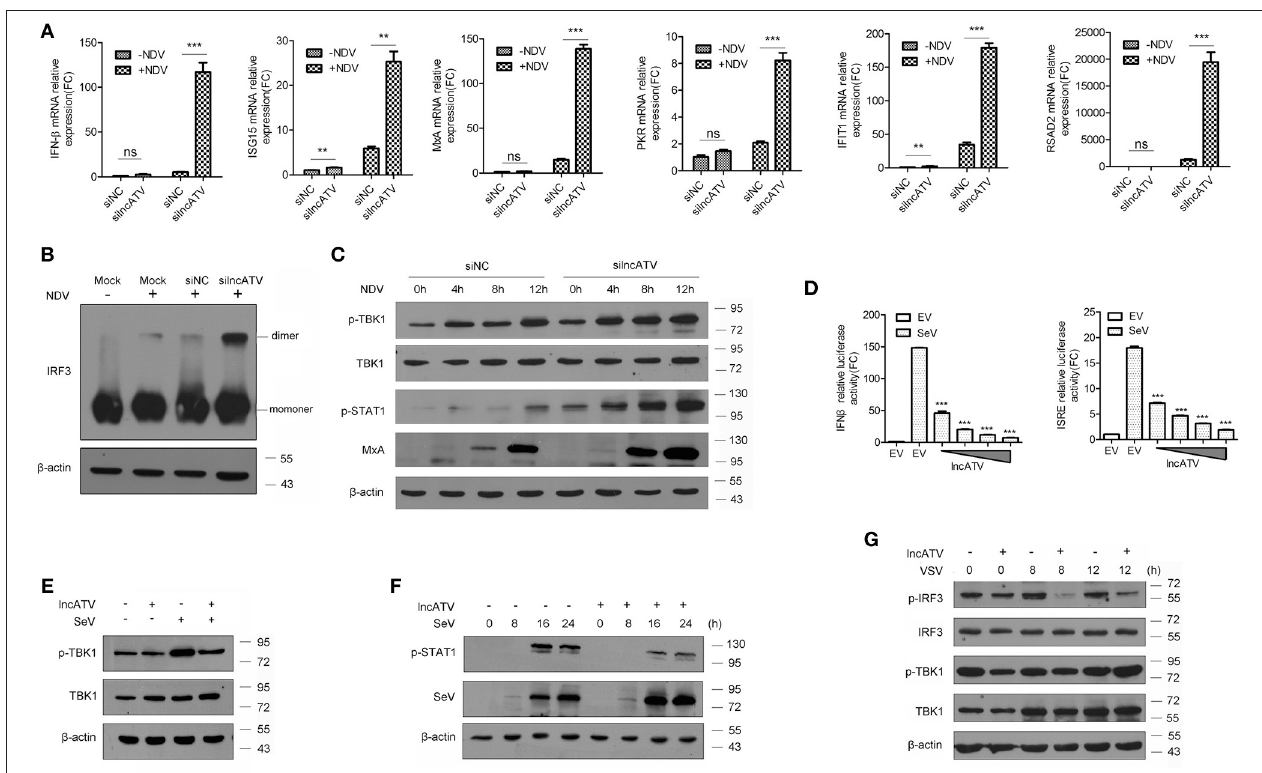
FIGURE 3 | Regulation of lncATV on the host innate immune response. (A) Huh7 cells were transfected with negative control siRNA (siNC) or siRNA targeting lncATV at 48h prior to infection. NDV (MOI = 0.01) was inoculated and allowed for another 16h infection to trigger innate immune response. Total RNA was isolated, and qRT-PCR was performed to measure the expressions of IFN β , ISG15, MxA, PKR, IFIT1, and RSAD2. (B) Dimerization of IRF3 was measured by native-PAGE and Western blotting. (C) Immunoblot analysis of phosphorylated proteins in lncATV knockdown and control Huh7 cells infected with NDV for indicated hours. (D) IFN β or ISRE promoter-driven reporter construct was co-transfected with either lncATV overexpressing plasmid or empty vector (EV) into HEK293T cells. Luciferase activities were determined in the absence or presence of SeV infection. (E,F) HEK293T cells were transfected with lncATV overexpressing plasmid or empty vector as controls and then challenged with SeV (MOI = 1) for the indicated time courses. Phosphorylated TBK1 (E) or STAT1 (F) was detected by Western blotting. (G) LncATV or control empty vector was overexpressed in Raw264.7 macrophage cells. The cells were infected with VSV (MOI = 0.5) for the indicated time courses and phosphorylated IRF3 and TBK1 were detected. Typical photographs of one representative experiment were shown. Data are representative of three independent experiments and plotted as the mean ± s.d. ** P < 0.01, *** P < 0.001 vs. the control group. NS, not